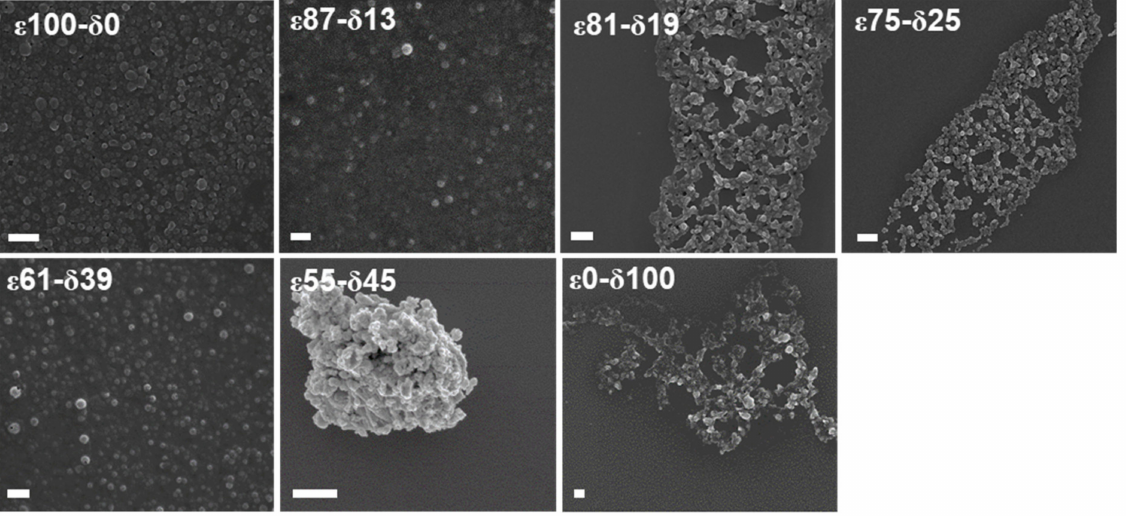
d H represents the intensity-weighted distribution (n ≥ 4 batches) and zeta-potential (ZP) (n = 3 ELS measurements) * Amorphous or near amorphous polymers with glass transition temperature T g below 37 ◦ C [17]. a Bulk degree of crystallinity as determined by wide-angle X-ray scattering (WAXS) at room temperature. b NPs measured after purification. c NPs measured after lyophilization and subsequent resuspension